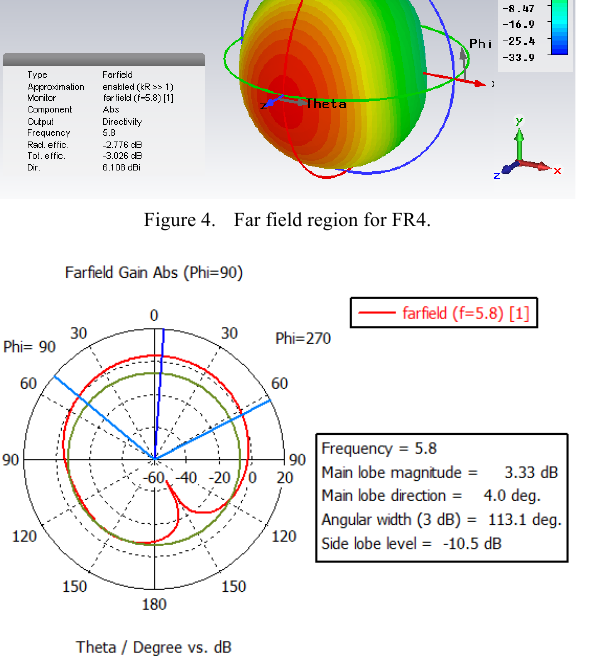
Figure 8. Far field in polar view for RTDuroid